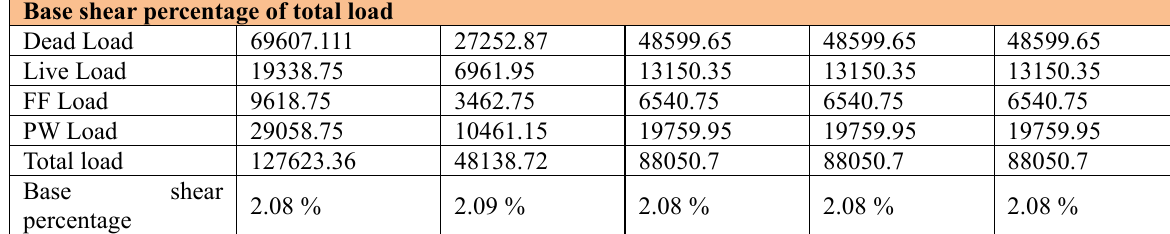
Base shear percentage of total load of the building.